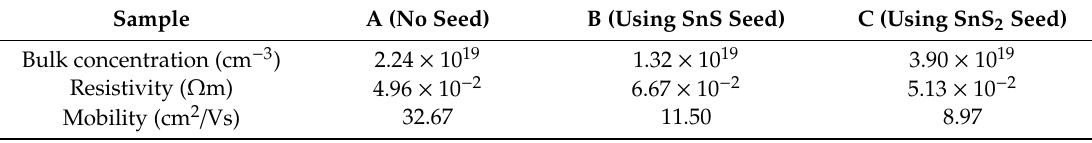
Table 3. Electrical properties of SnS films using various seed layers by the Hall effect measurement.